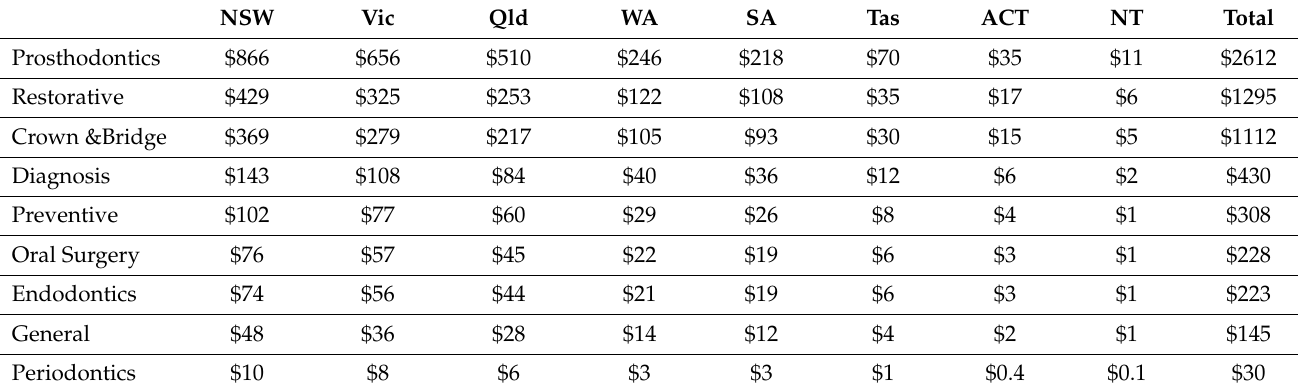
Table 3. Cost (million Australian dollars, AUD) of dental services of older population by states and territories. NSW Vic Qld WA SA